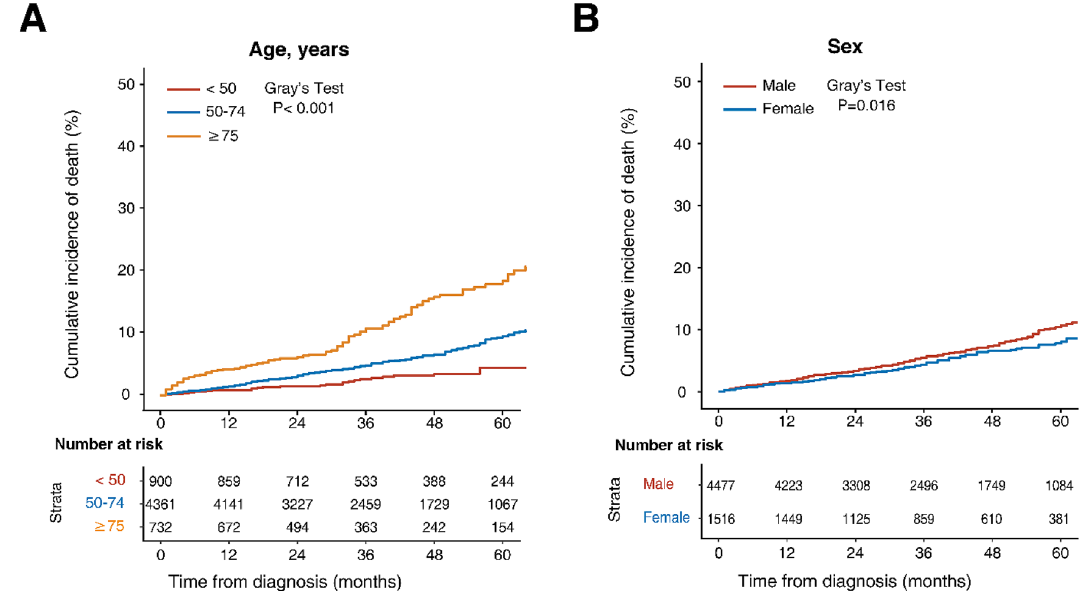
Figure 4. Cumulative incidences curves of OCM according to age ( A ) and sex ( B ). The differences between groups were assessed by Gray’s test. OCM other-cause mortality. The figure was performed using R software (version 4.0.3, R Core Team 2020, https:// www.r- proje ct. org/).